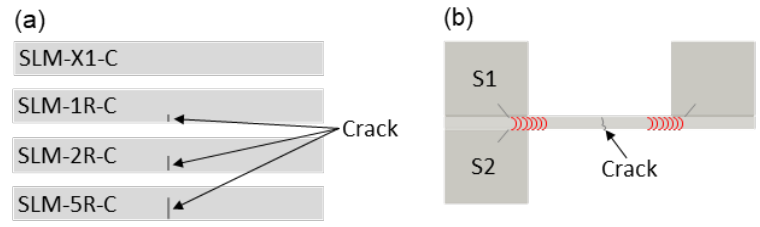
Figure 1. Experiments ( a ) Specimen—overview; ( b ) Experimental setup—principle.